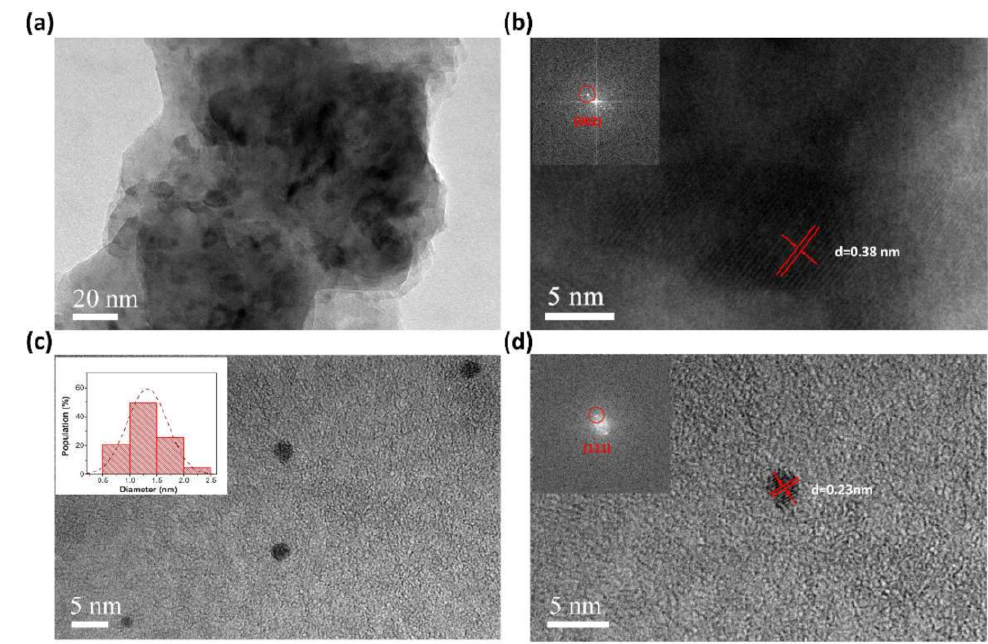
Figure 5. TEM images of MLGPs in MLGP/PAA hydrogel ( a , b ) and Ag 0 in MLGP/ Ag 0 /PAA hydrogel ( c , d ). The inset in ( c ) is the size histogram of 150 silver nanoparticles in MLGP/ Ag 0 /PAA